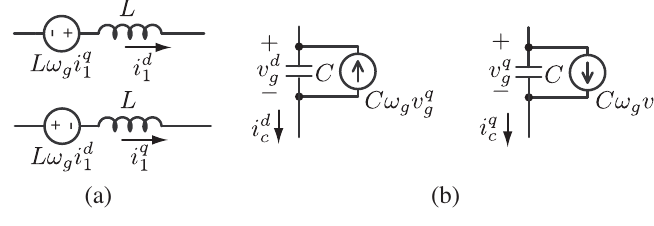
Figure 4. Inductor ( a ) and capacitor ( b ) in the dq reference